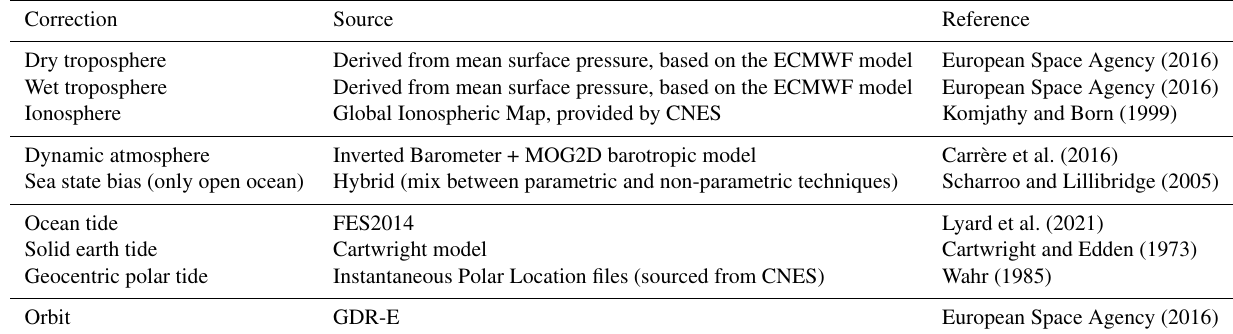
Figure 2. Characterization of the respective η (cid:48) bias over leads and open ocean. (a) Scatter plot of AWI (ice-covered) and RADS (ice-free) η (cid:48) observations for July 2015 prior to correcting the offset. The black solid line indicates the 15% sea ice concentration as derived from the OSI SAF ice concentration products (archive OSI-401-b, available at ftp://osisaf.met.no/archive/ice/conc/, last access: 3 February 2022). (b) Steric height plus ocean bottom pressure ( h S + h P ) versus η for the ice-covered altimetry data (AWI) and ice-free altimetry data (RADS). Vertical bars indicate the offset between the two altimetry datasets and h S + h P . Panels (c) and (d) show the grid points where h S + h P data points overlap with along-track η data points from the AWI (green, panel c ) and RADS (blue, panel d ). Table 3. Altimetry corrections applied in this study. Abbreviations: ECMWF (European Centre for Medium-Range Weather Forecasts); CNES (Centre National d’Etudes Spatiales); MOG2D (Modèle d’ondes de gravité 2D); FES2014 (Finite Element Solution 2014); GDR-E (Geophysical Data Record, version